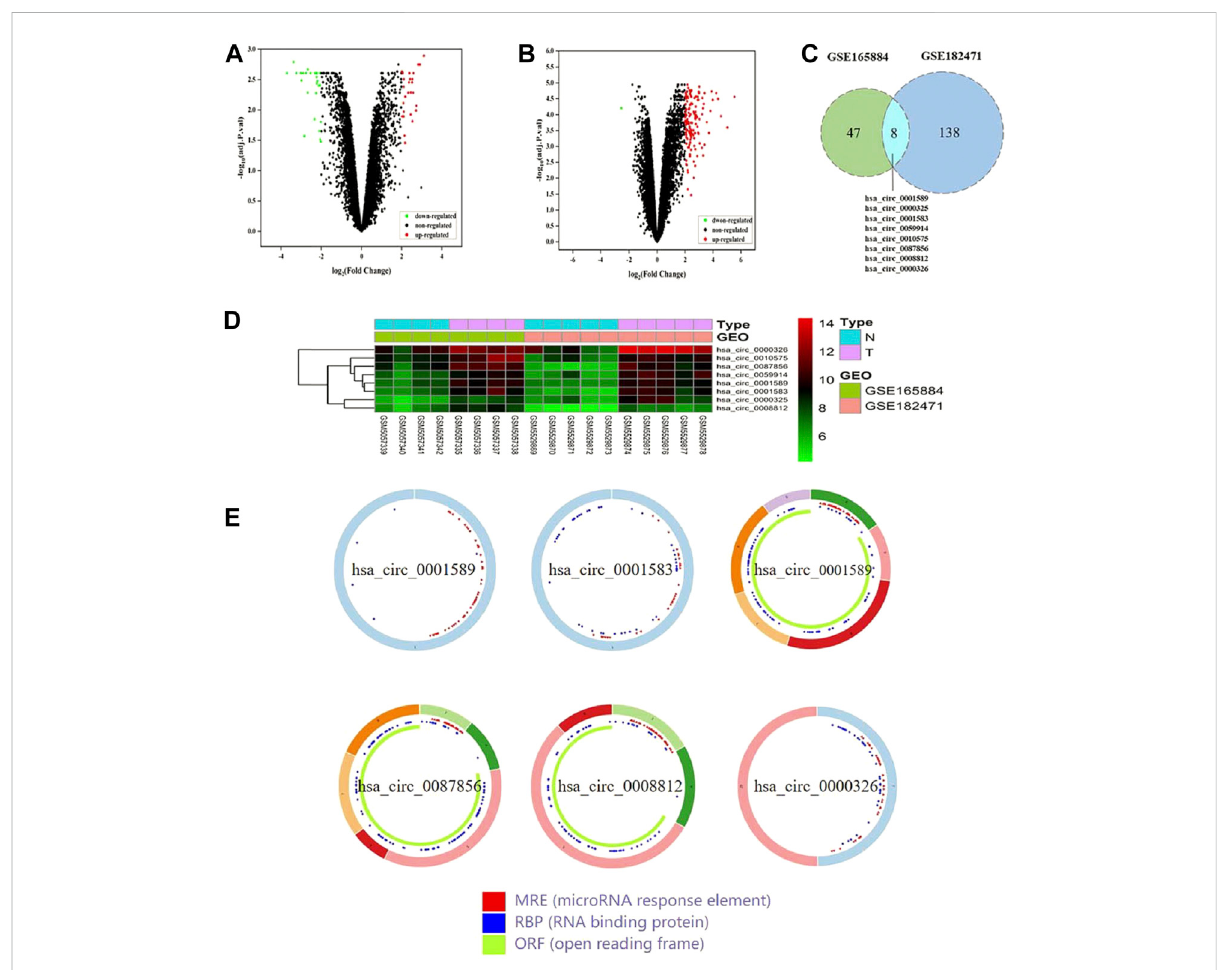
FIGURE 2 The identi fi cation of DEcircRNAs in two datasets. (A) Volcano plot of GSE165884. (B) Volcano plot of GSE182471. (C) Identi fi cation of overlapping DEcircRNAs from GSE165884 and GSE182471. (D) Heatmap of the overlapping 8 DEcircRNAs. (E) The structural patterns of the 6 DEcircRNAs from